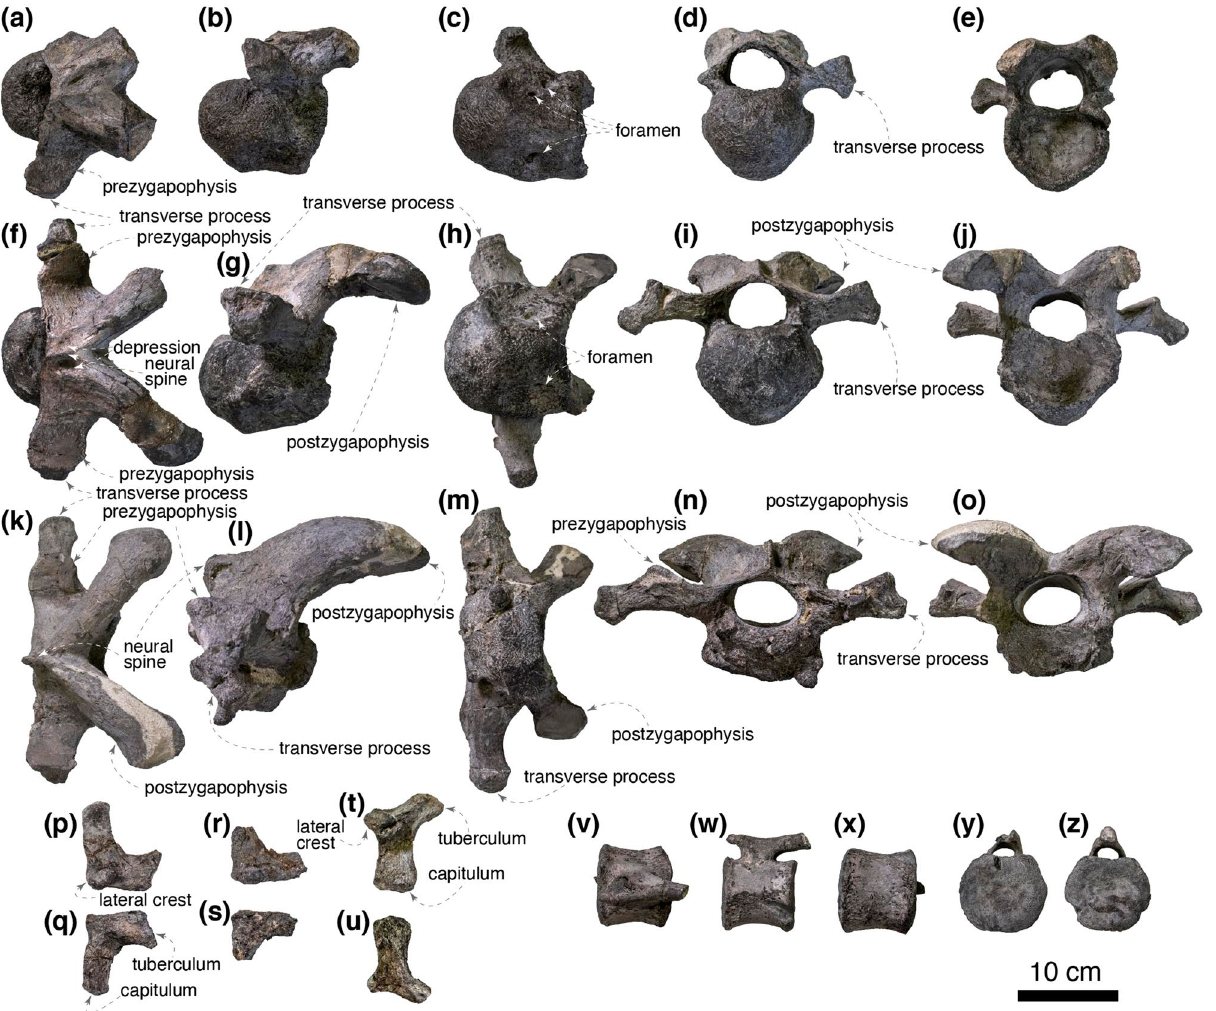
Figure 5. The fourth or fifth cervical vertebra of Yamatosaurus izanagii gen. et sp. nov. in dorsal ( a ), left lateral ( b ), ventral ( c ), anterior ( d ), and posterior ( e ) views. The fifth or sixth cervical vertebra of Yamatosaurus izanagii gen. et sp. nov. in dorsal ( f ), left lateral ( g ), ventral ( h ), anterior ( i ), and posterior ( j ) views. A middle cervical vertebra (seventh to ninth) of Yamatosaurus izanagii gen. et sp. nov. in dorsal ( k ), left lateral ( l ), ventral ( m ), anterior ( n ), and posterior ( o ) views. Cervical ribs of Yamatosaurus izanagii gen. et sp. nov. in dorsomedial ( p , r , t ) and ventrolateral ( q , s , u ) views. A distal caudal vertebra in dorsal ( v ), left lateral ( w ), ventral ( x ), anterior ( y ), and posterior ( z )